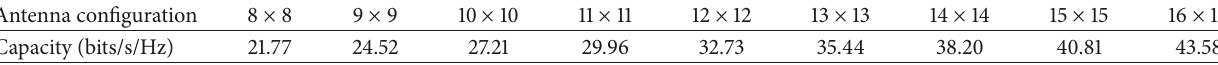
Table 7: Rayleigh channel from 8 × 8 to 16 × 16 MIMO